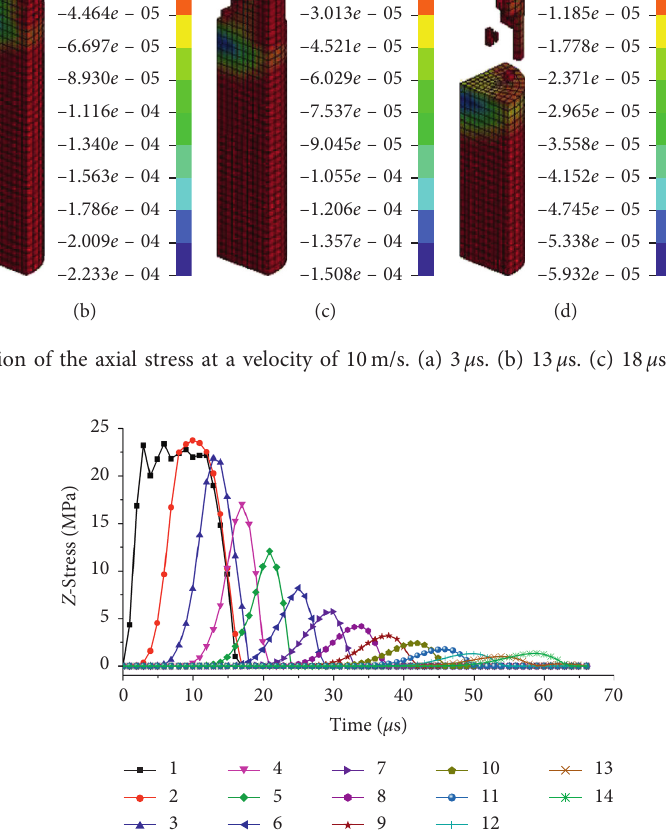
Figure 13: Axial stress time history on the central